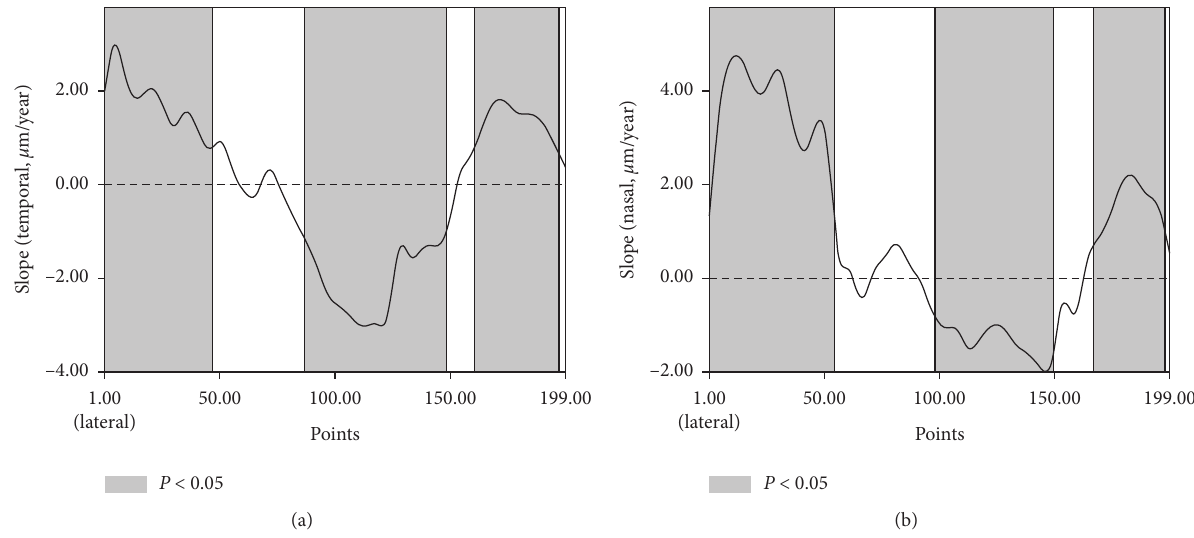
Figure 3: Variation of iris thickness with age ( μ m/year): temporal iris (a) and nasal iris (b). Filled: the correlation was statistically significant ( P < 0.05).